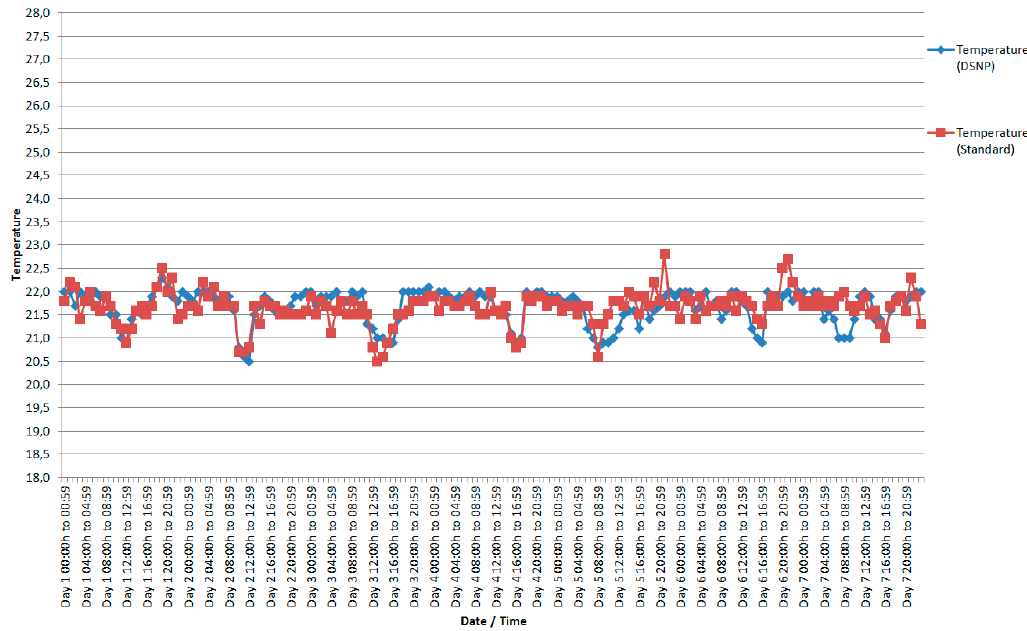
Figure 7. Average temperatures recorded by the standard shape sensors and average temperatures of the sensors recorded using